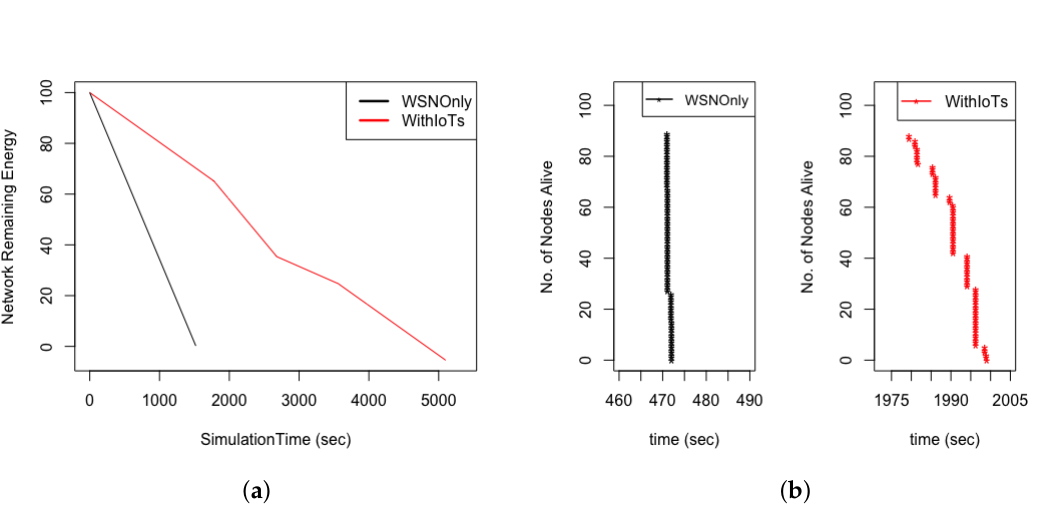
Figure 9. ( a ) Network lasts four times longer by using IT Platform that uses IoT devices. ( b ) [Left] All nodes die instantly, [Right] Nodes die in slow fashion using IT